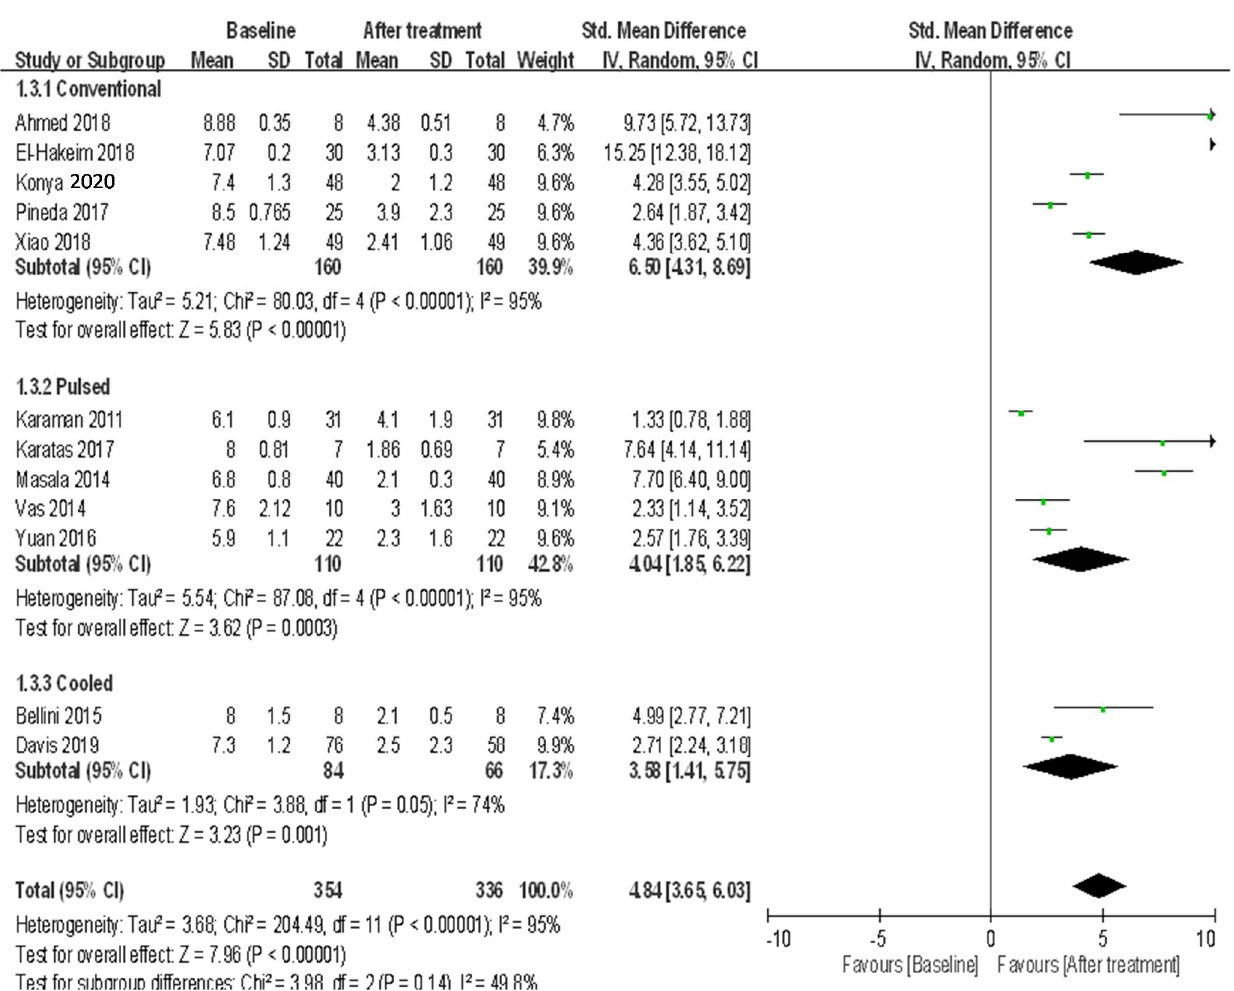
Figure 4. Meta-analysis of efficacy in pain using three radiofrequency ablation techniques to treat knee OA at the 6-month follow-up.